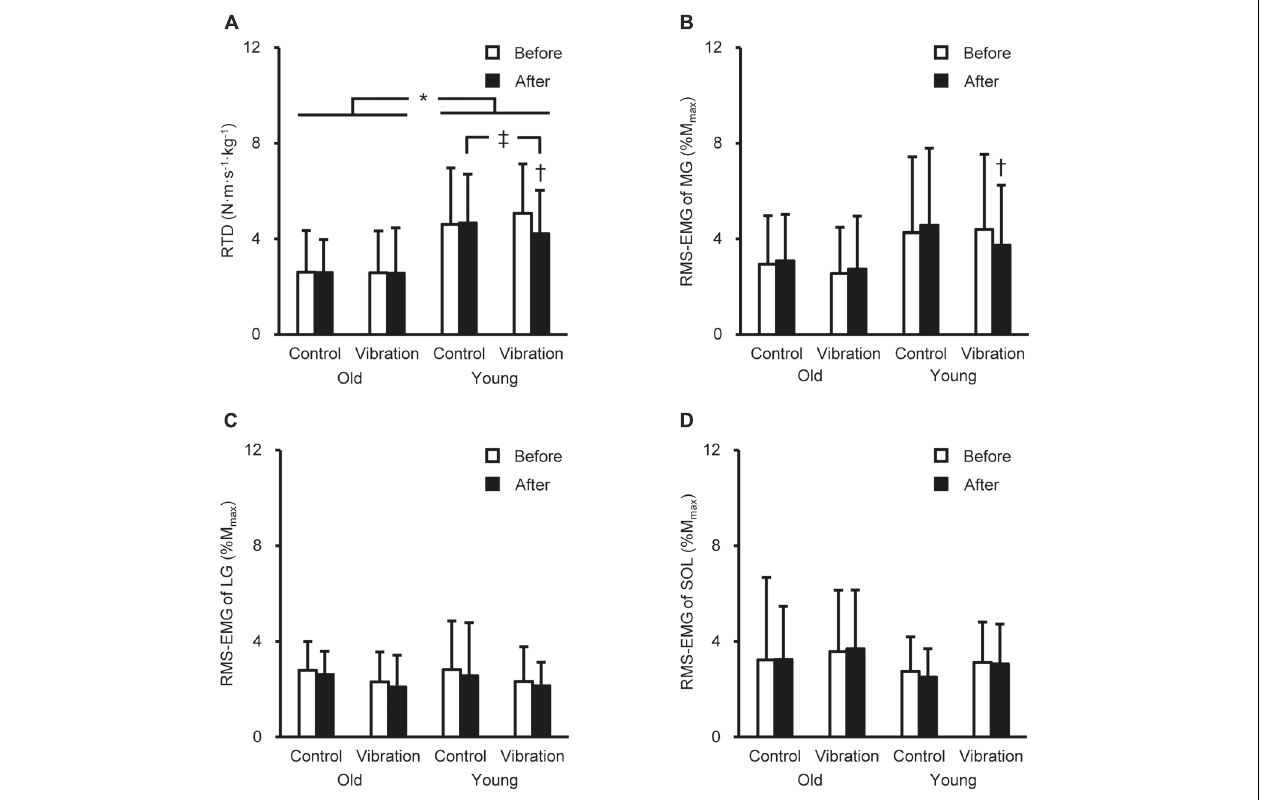
FIGURE 2 | Rate of torque development (RTD, A ) of plantar flexion and root mean square of the electromyogram (RMS-EMG) during explosive contraction of the medial gastrocnemius (MG, B ), lateral gastrocnemius (LG, C ), and soleus (SOL, D ) before and after the intervention. Data are shown as mean + standard deviation. RTD was defined as the slope of the time-torque curve during time intervals of 0–100 ms from the onset of plantar flexion. RMS-EMGs of the triceps surae were normalized to the peak-to-peak compound muscle action potential amplitude at rest (M max ). *Indicates a significant difference between older and young men. † Denotes a significant change after the intervention. ‡ Shows a significant difference between control and vibration